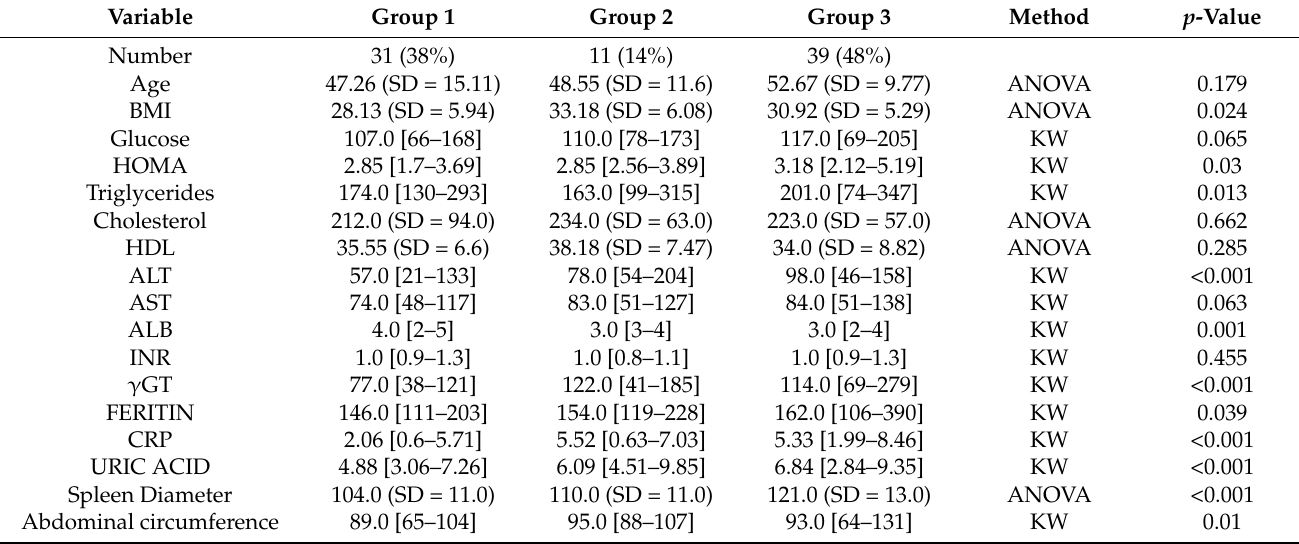
Table 2. Extended patient characteristics, by study